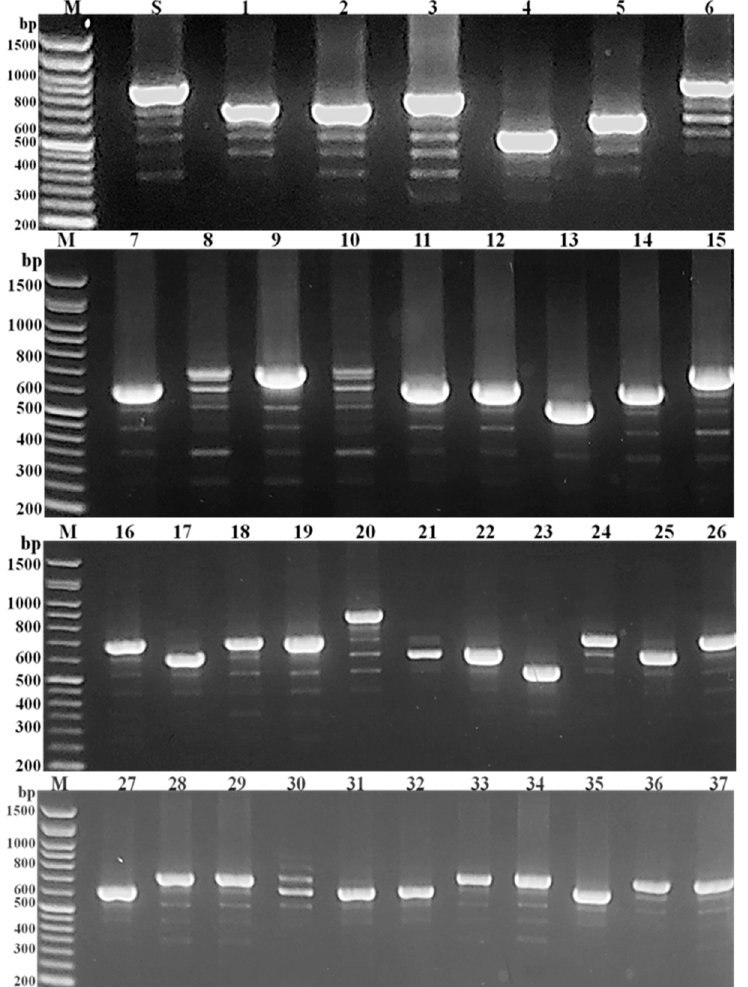
Figure 2. Agarose gel (1.5%) electrophoresis of coa gene PCR products. Lanes, M; 50 bp DNA ladder, S; S. aureus ATCC 6538, and 1 to 37; showed the coa gene variable bands size, number, and intensity in the tested MRSA isolates number 1–37, respectively.